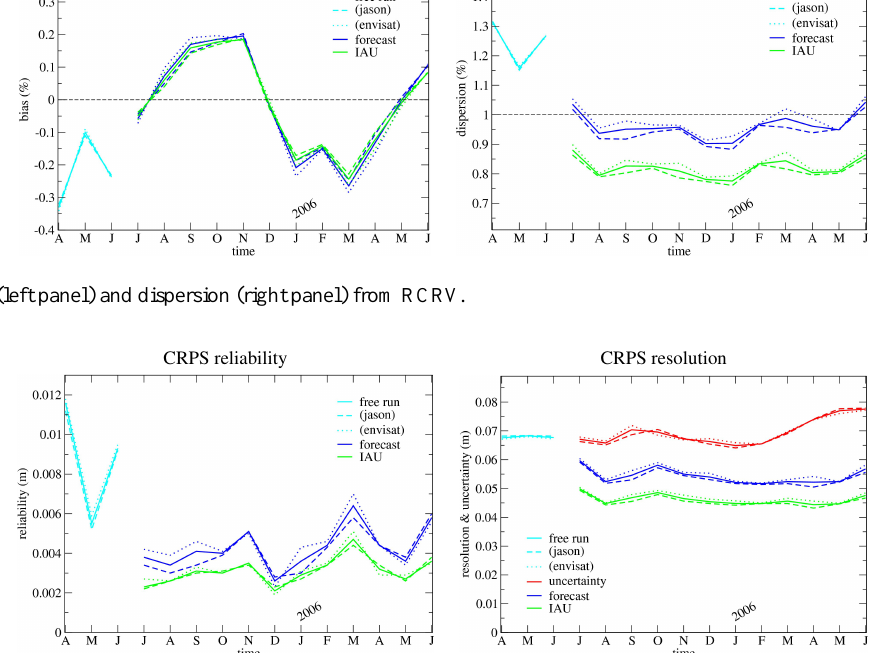
day forecast ensemble and observations are truly indepen- dent